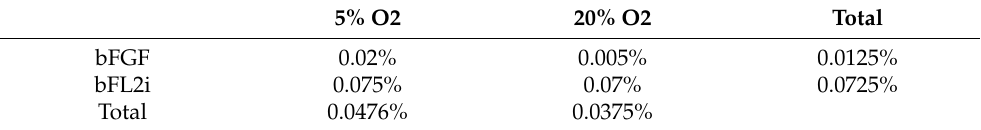
Table 2. Efficiency of reprogramming at D14 (number of colonies observed in relation to number of cells plated) derived in 5% and 20% oxygen tension and cultured with bFGF or bFL2i